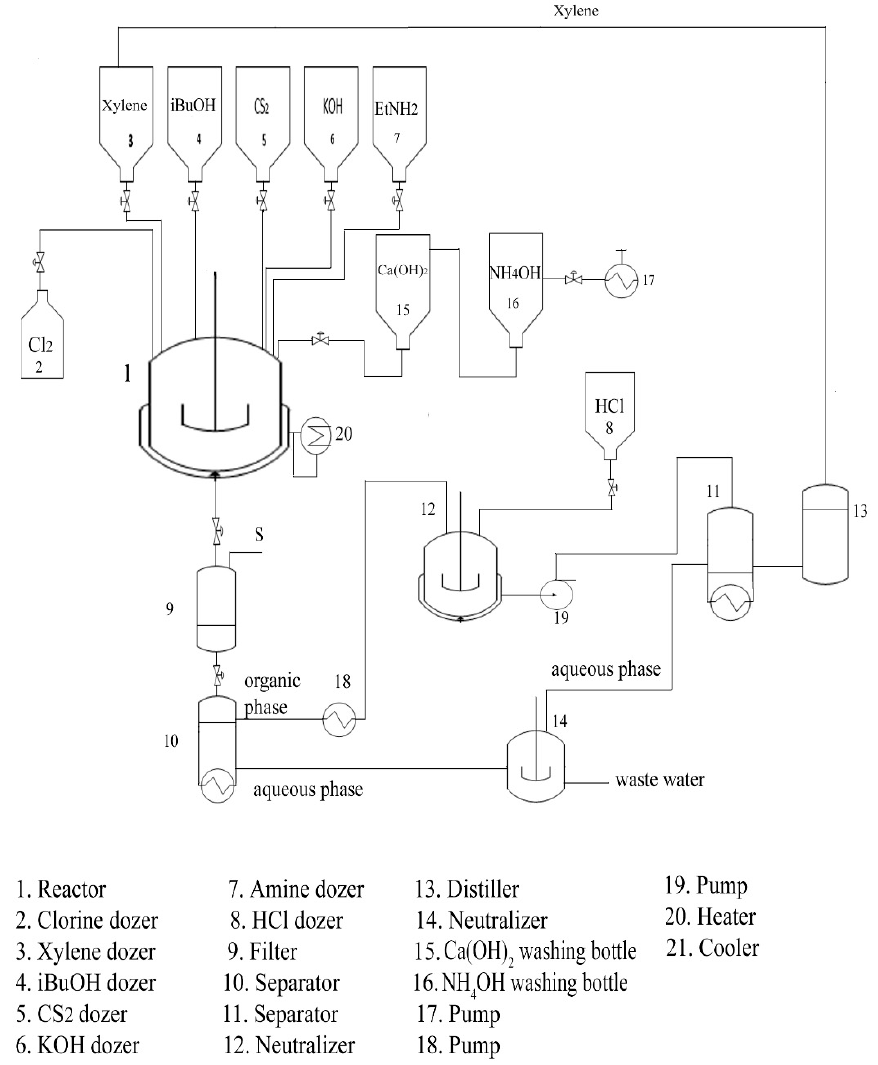
Figure 7. Proposed schematic presentation of the technological process of N ‐ alkyl, N , N ‐ dialkyl, and N -cikloalkyl- O -isobuthyl N ‐ cikloalkyl ‐ O ‐ isobuthyl thiocarbamate.